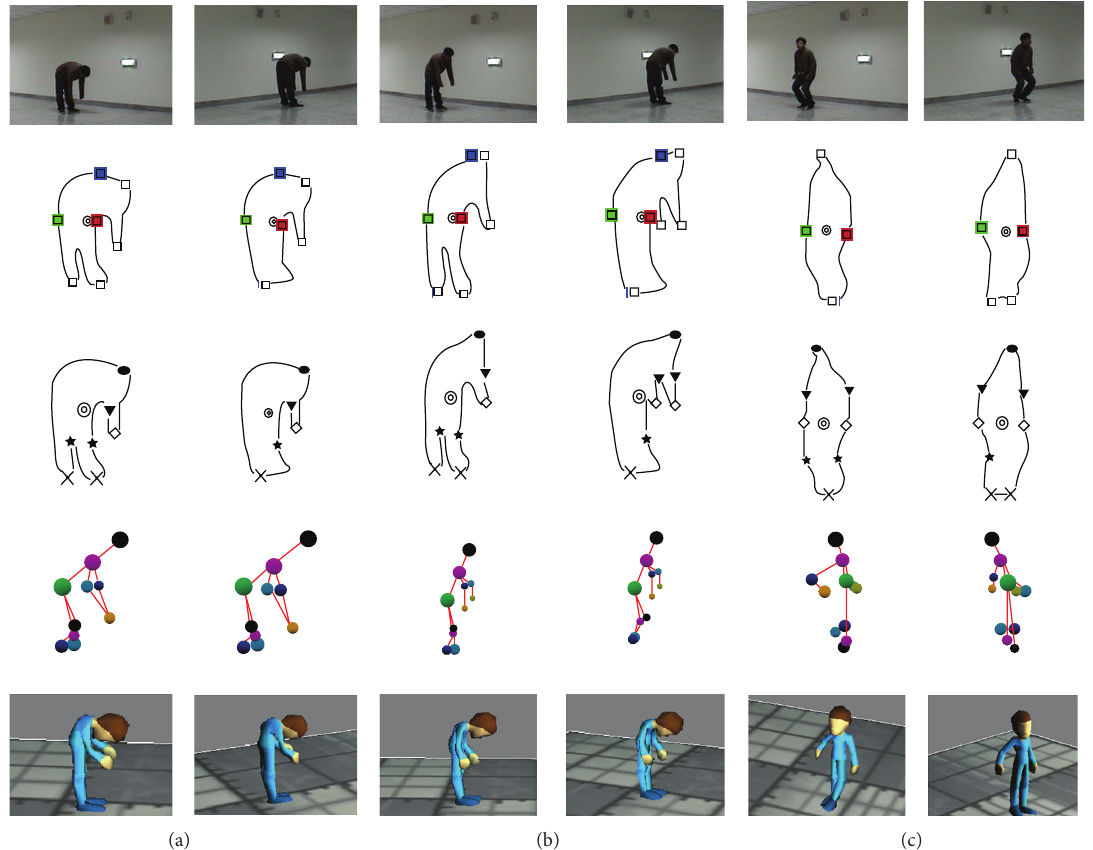
Figure 12: Experimental results of bending postures in Experiment 3, where notations of the points are the same as those in Figure 11.